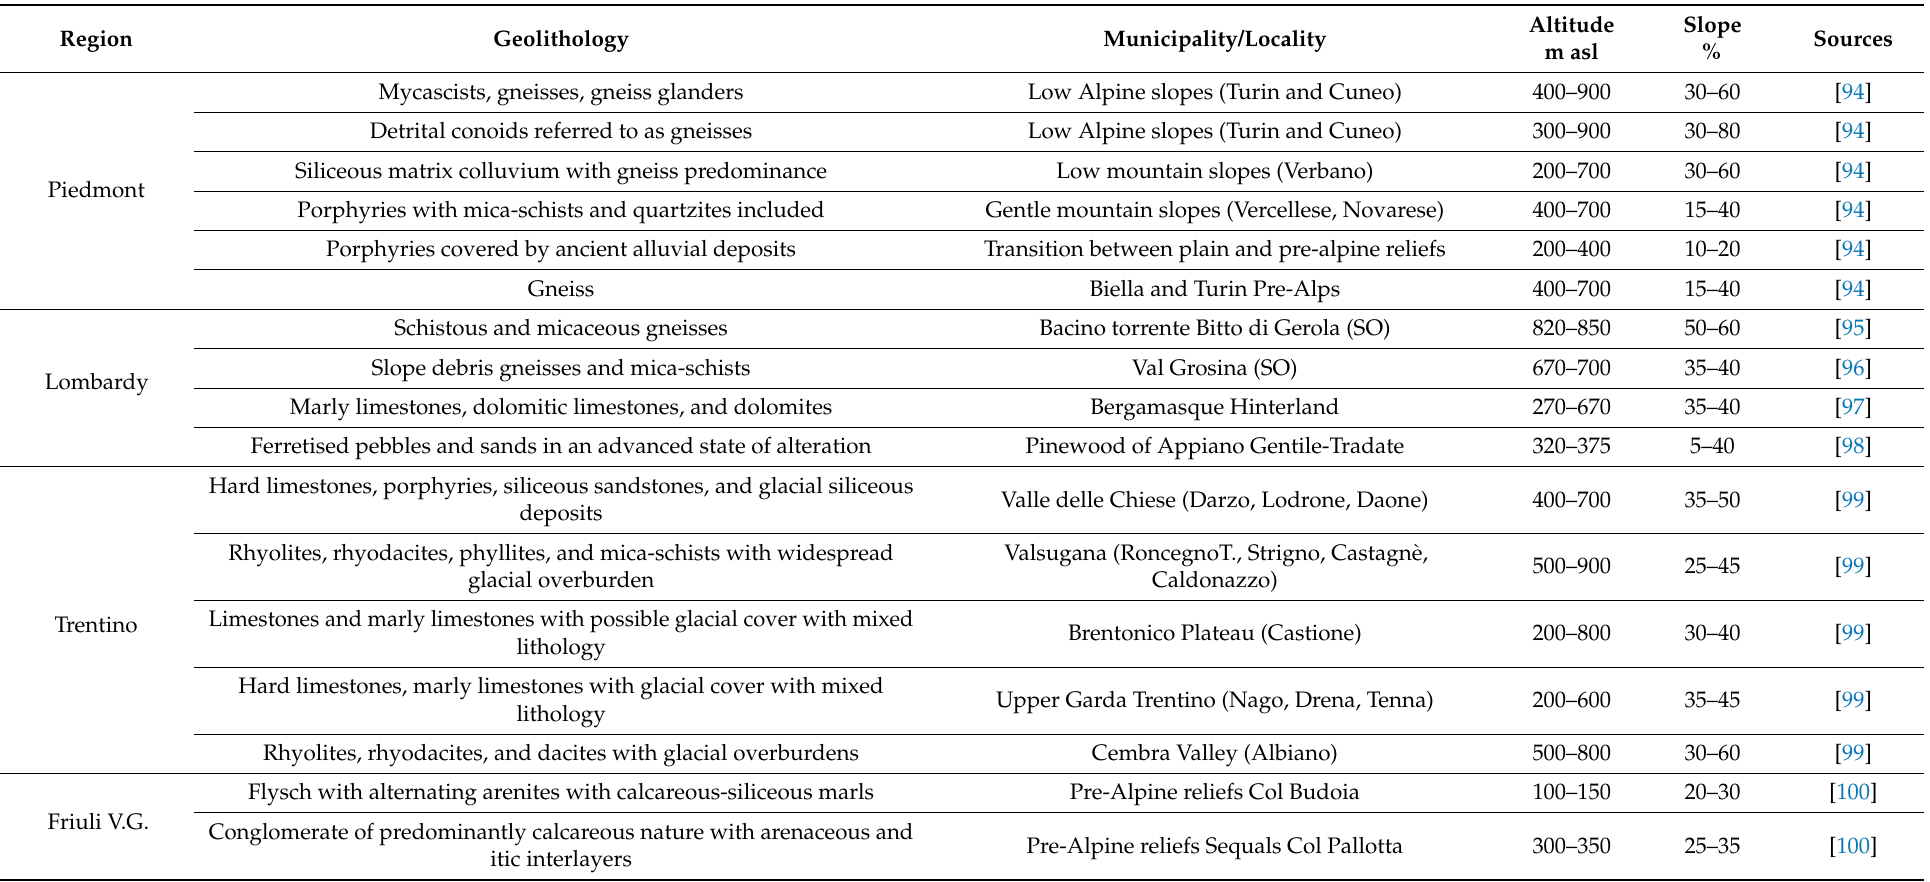
Table A1. Geolithological formation types and morphological features of Italian areas currently under chestnut stand cultivation for fruit production